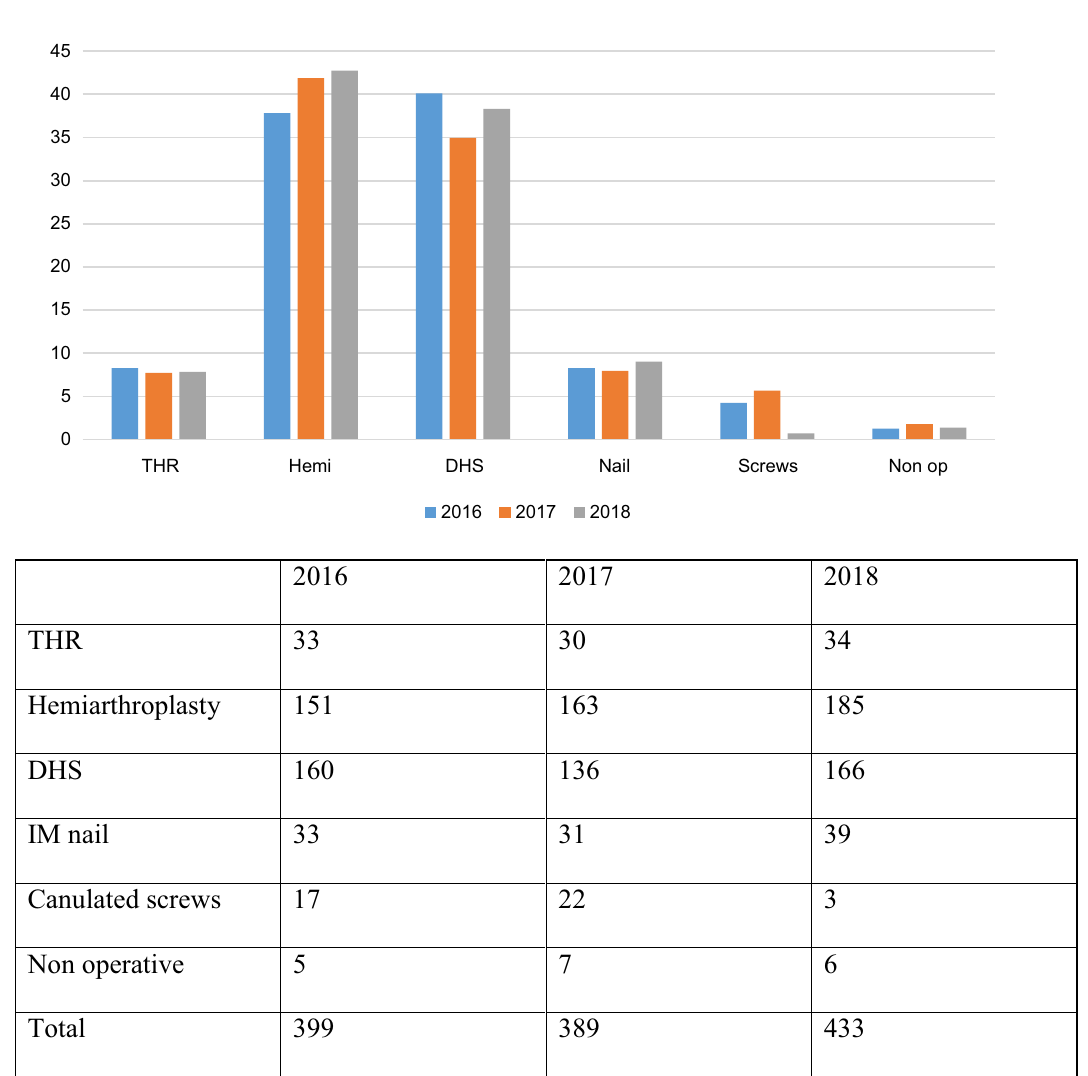
Figure 1. Various NOF fracture treatments